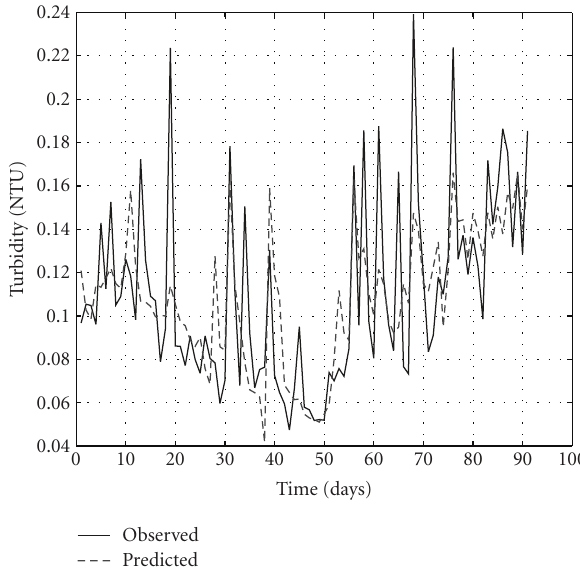
Figure 3: Observed turbidity and the values predicted by the MLR model when using the 8 best